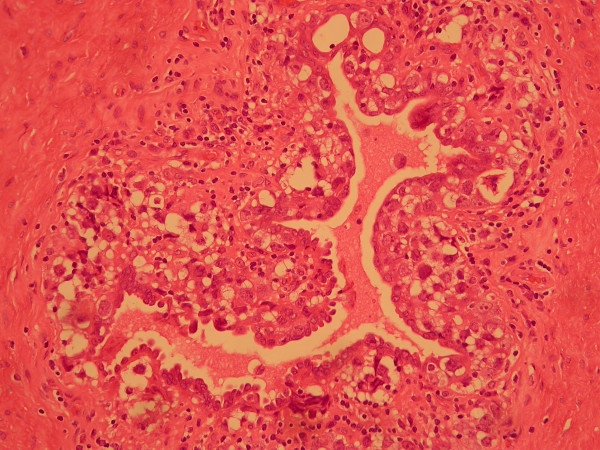
Histological appearance of left vas deferans with sub epithelial seminoma cells.